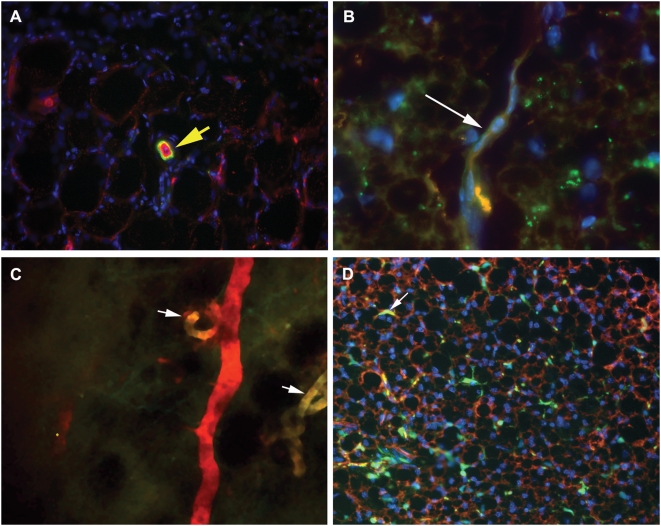
Imaging of adipose tissue vasculature in GFP transgenic mice.
A: Incorporation of BMD-EC in mammary fat pad vasculature in WT/Tie2-GFP-BMT mice. B: Ex vivo confocal microscopy imaging of mammary fat pad in two mice with age-related obesity (∼18 months old). BMD-EC contributed to approximately 8% of the mammary fat pad vasculature. C: Representative image of GFP+ BMD-EC in the mammary fat pad of an obese mouse after 6 weeks on a high fat diet. BMD-EC contribution to mammary fat pad vasculature was minimal (0.8%, n = 4). Vessels were perfused with biotinylated-lectin and stained with streptavidin Texas Red (shown in red), while the nuclei were stained with DAPI (in blue, A, B). Rhodamine-dextran MW 2,000,000 was infused for vessel enhancement in C. D: Representative image of occasional GFP+ BMD-EC (arrow) in perfused mammary fat pad blood vessels in a 12 months old WT/Actb-GFP-BMT mouse. Vessels were perfused with biotinylated-lectin and stained with streptavidin Texas Red (red), while the nuclei were stained with DAPI (blue). Images are 1.72 mm across in A, 310 µm across in B, 700 µm across in C, 1.72 mm across in D.